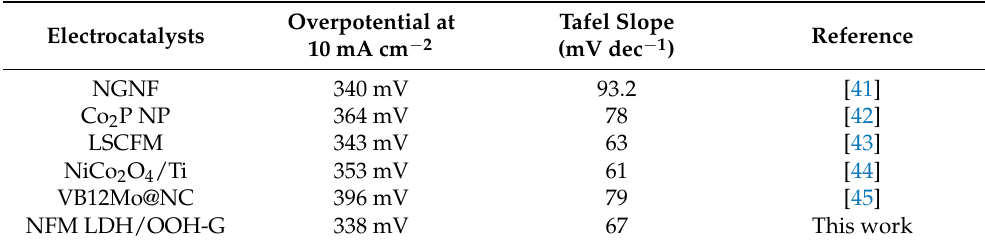
Table 1. Comparison of the characteristic OER performance between the prepared NFM LDH/OOH- G and other reported non-noble electrocatalysts in the